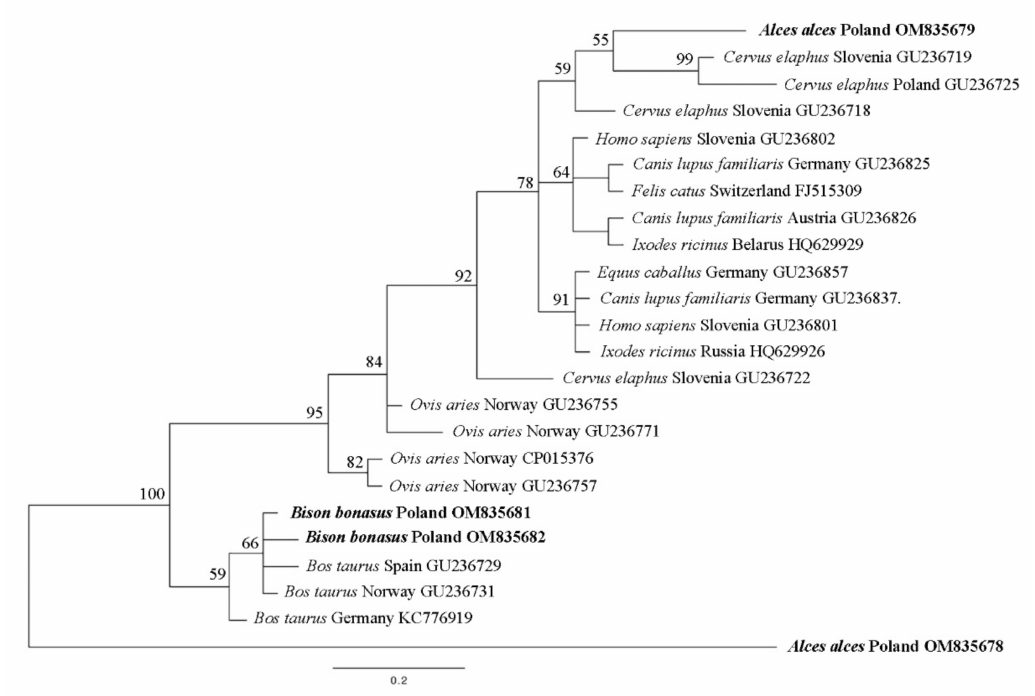
Figure 3. Phylogenetic tree of ankA partial gene (630 bp) haplotypes from Anaplasma phagocy- tophilum, constructed by Bayesian inference (BI) analysis using MrBayes version 3.2. The GTR + I + G model was chosen as the best-fitting nucleotide substitution model using JModelTest version 2.1.10 software. The scale bars are proportional to the number of substitutions per site. In bold, sequences from this